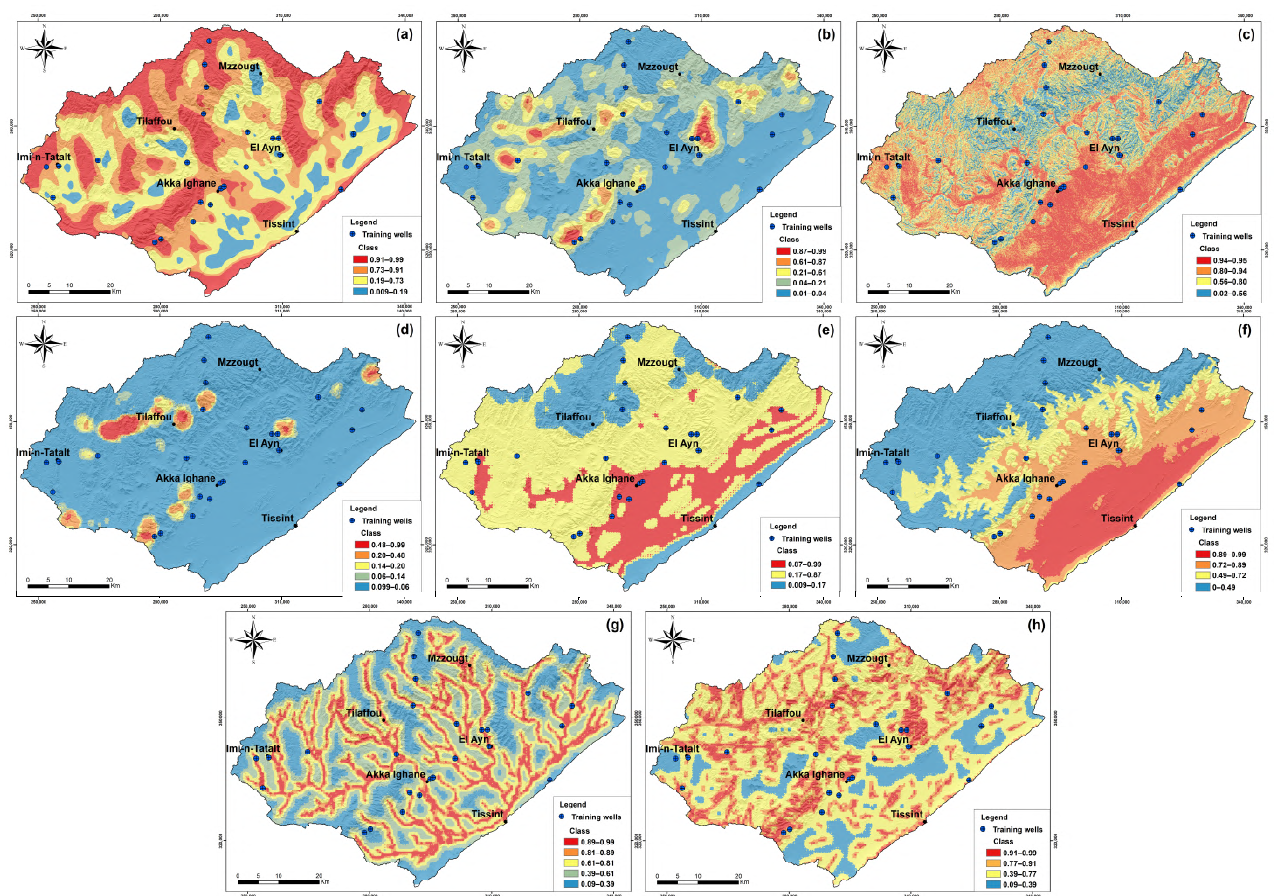
Figure 6. Classified map for the transformed values: ( a ) drainage density map; ( b ) lineament density map; ( c ) slope map; ( d ) node density map; ( e ) permeability map; ( f ) altitude map; ( g ) distance from rivers map; ( h ) distance from lineament map.